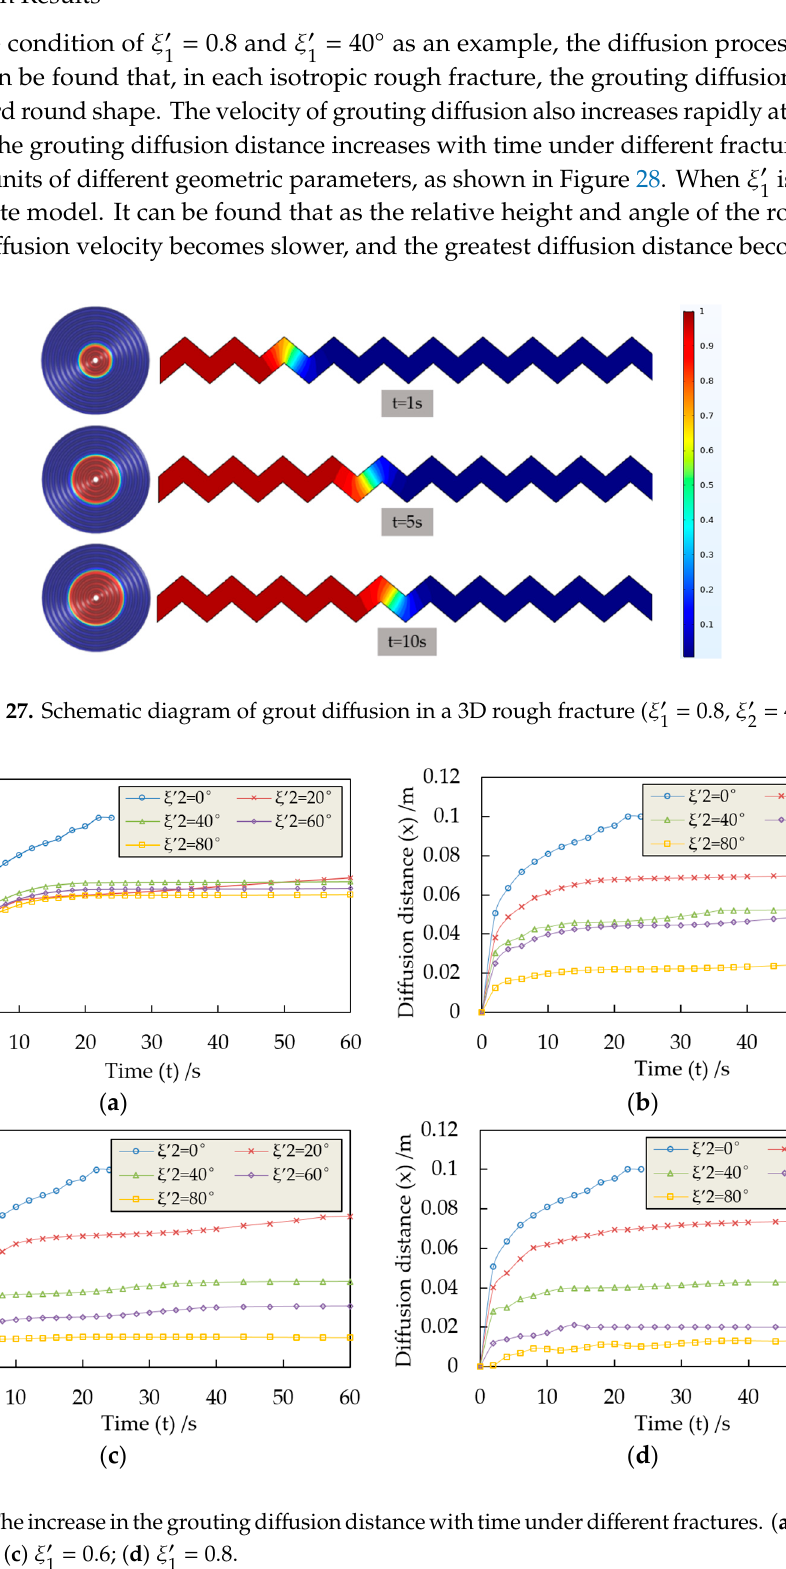
Figure 28. The increase in the grouting diffusion distance with time under different fractures. (a) Figure28. Theincreaseinthegroutingdi ff usiondistancewithtimeunderdi ff erentfractures. ( a ) ξ (cid:48) = 0.4; ( c ) ξ (cid:48) = 0.6; ( d ) ξ (cid:48) = ( b ) ξ (cid:48) 1 1 1 ' ' ' ξ = 0.4; (c) ξ = 0.6; (d) ξ = 0.8. = 0.2; (b) 1 1 1